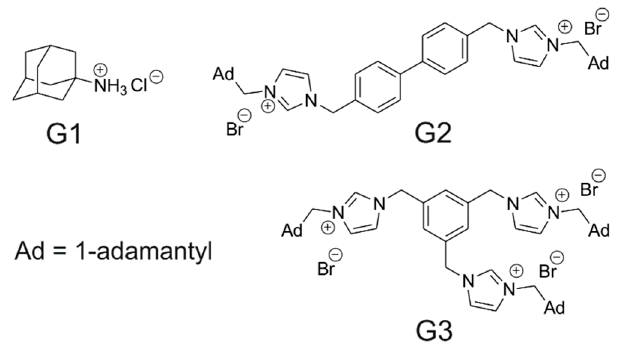
Figure 1. The adamantane-based supramolecular guests used in this study.